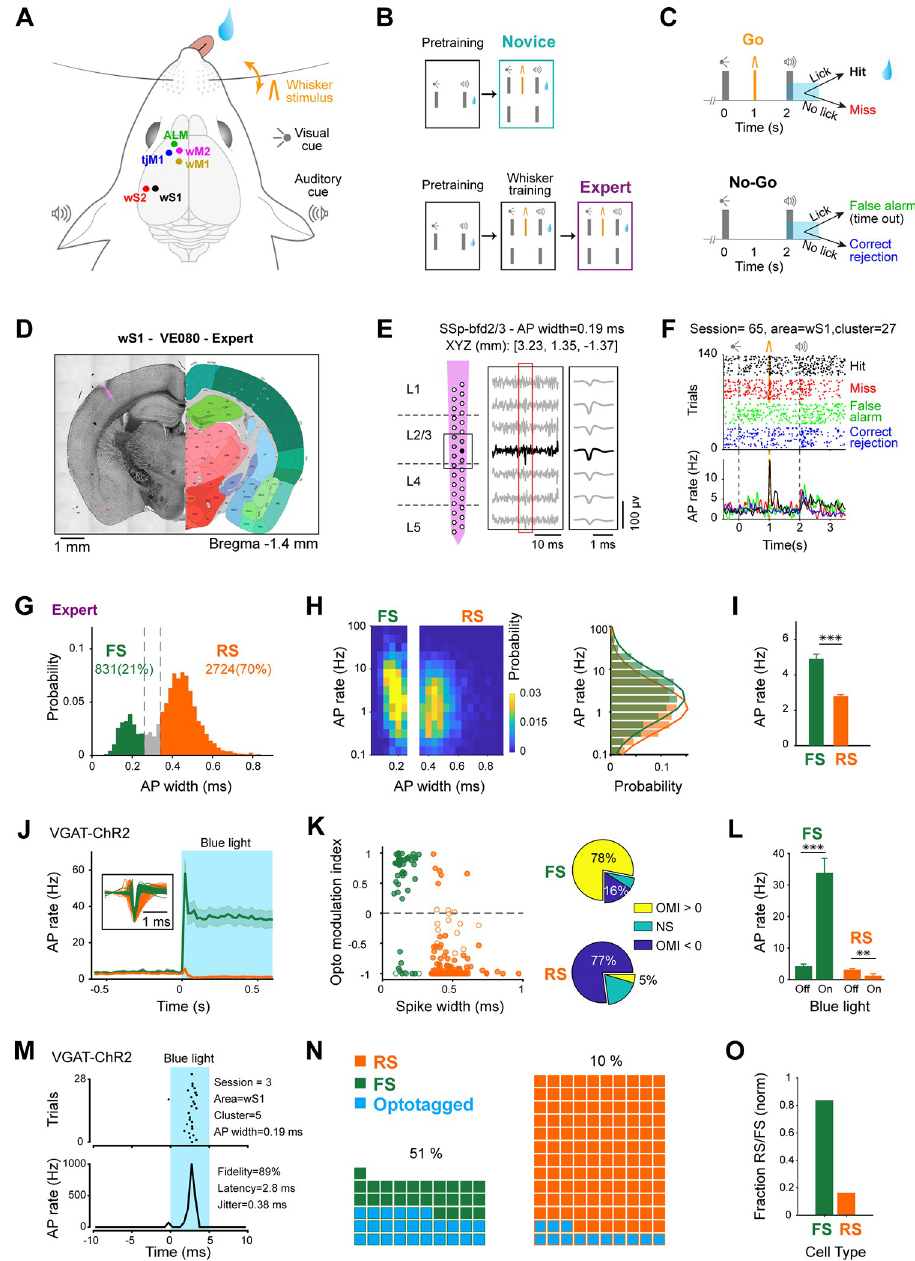
Fig 1. Multiarea recordings during delayed whisker detection task and assignment of RS and FS units to cortical subdivisions. (A) Schematic of the whisker detection task with delayed response and the targets of silicon probe recordings. (B) Training paradigm. Novice and Expert mice were first pretrained in a task, where licking after the auditory cue was rewarded. Expert mice were further trained to only lick in whisker trials. (C) Final task structure used during recording sessions (for both groups of mice) and behavioral outcomes. (D) Example coronal section of an Expert mouse brain with fluorescent track of a probe in wS1, registered to the Allen Mouse Brain Atlas, https://mouse. brain-map.org [47]. (E) Reconstructed laminar location of recording sites of the silicon probe shown in (D) according to the Allen Atlas (left); filtered recorded raw data of 7 sites around one detected spike; and average extracted spike waveform for this example neuron (right). After spike sorting, the position of each cluster (i.e., neuron) was assigned to the location of recording site with the largest spike amplitude (filled circle), and spike width was calculated on the average spike waveform from this site. (F) Raster plot and peri-stimulus time histogram for the example neuron shown in (E). Trials are grouped based on outcome. (G) Spike width distribution for neurons recorded in Expert mice. Neurons were categorized as FS (spike width < 0.26 ms) or RS (spike width > 0.34 ms). Neurons with